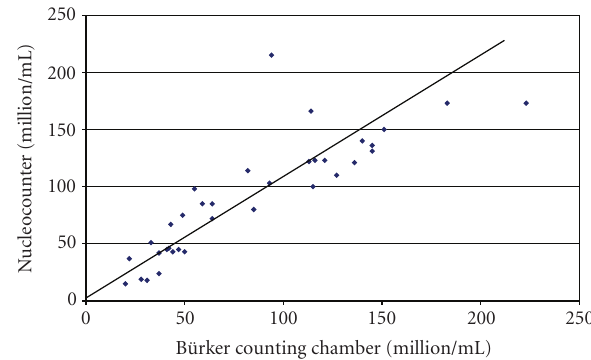
Figure 1: Relationship between sperm concentration measured with the Nucleocounter SP-100 and with the B¨urker counting chamber ( n =